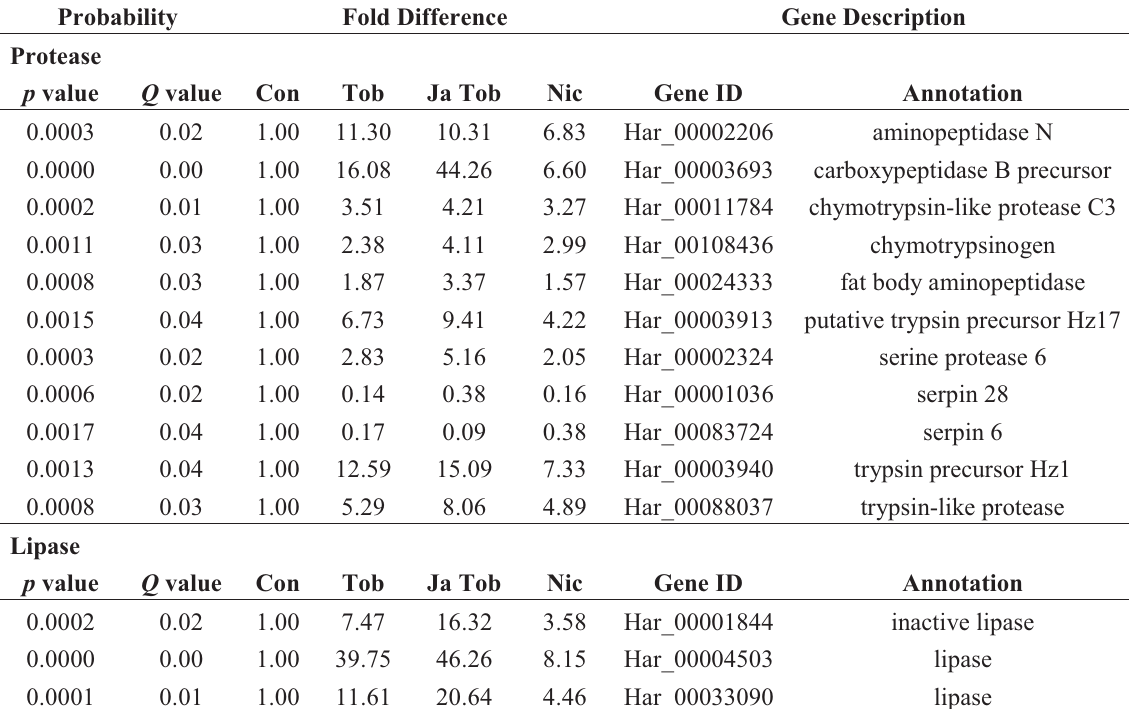
Table 2. Expression of proteases, lipases, and chitin and cuticle related genes. Gene name, fold change and NCBI reference sequence are